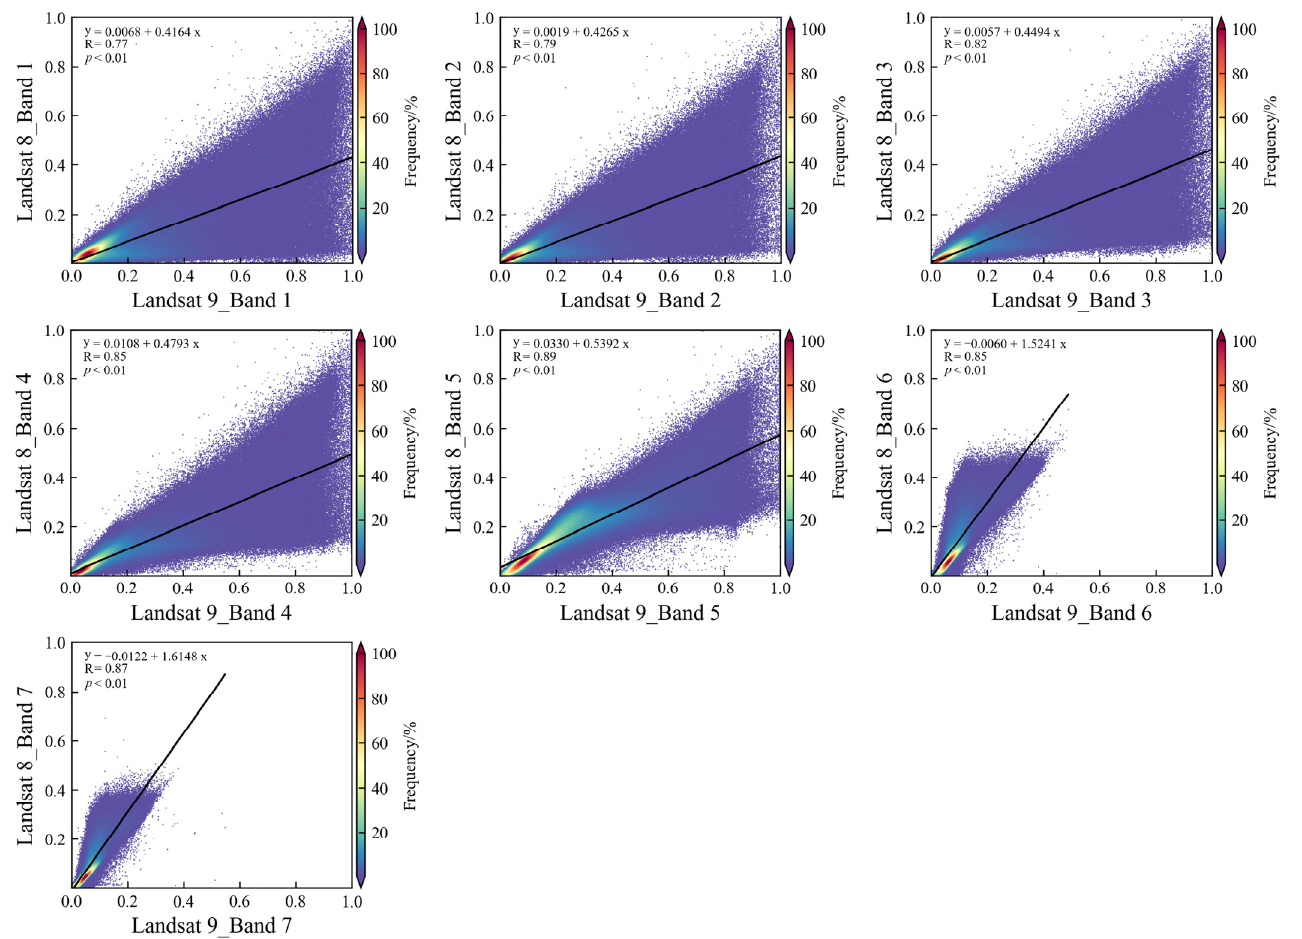
Figure 2. The scatter plots of Band 1 to Band 7 of Landsat 8 and Landsat 9 images in Wangyedian. In addition, the means and standard deviations of Band 1 to Band 5 of Landsat 8 were smaller than those of Landsat 9 but larger for Band 6 and Band 7. However, the coefficients of variation of Band 1 to Band 5 of Landsat 8 were smaller than those of Landsat 9. In general, the band values of both Landsat 8 and Landsat 9 were similar, and Landsat 9 has land surface (Table 4). Table 4. Statistical eigenvalues of bands of Landsat 8 and Landsat 9 in Wangyedian.